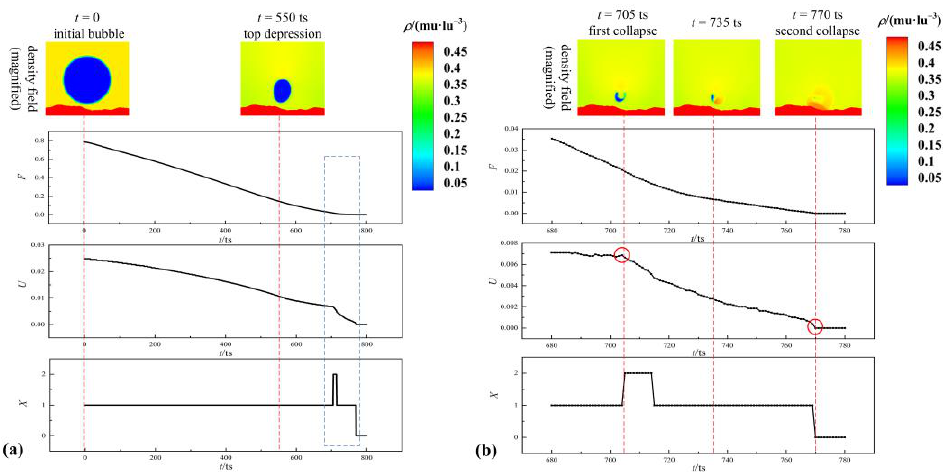
Figure 8. Time evolution of Minkowski measures for the collapsing bubble near a solid wall with complex geometry. ( a ) the whole process from t = 0 to t = 800 ts, ( b ) the part process from t = 680 ts to t = 780 ts .